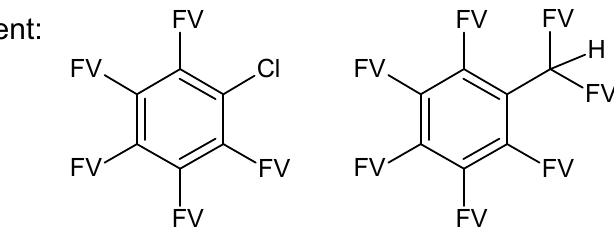
Figure A3. Substructures for GC–MS Challenges 3 and 4. FV = free valence.